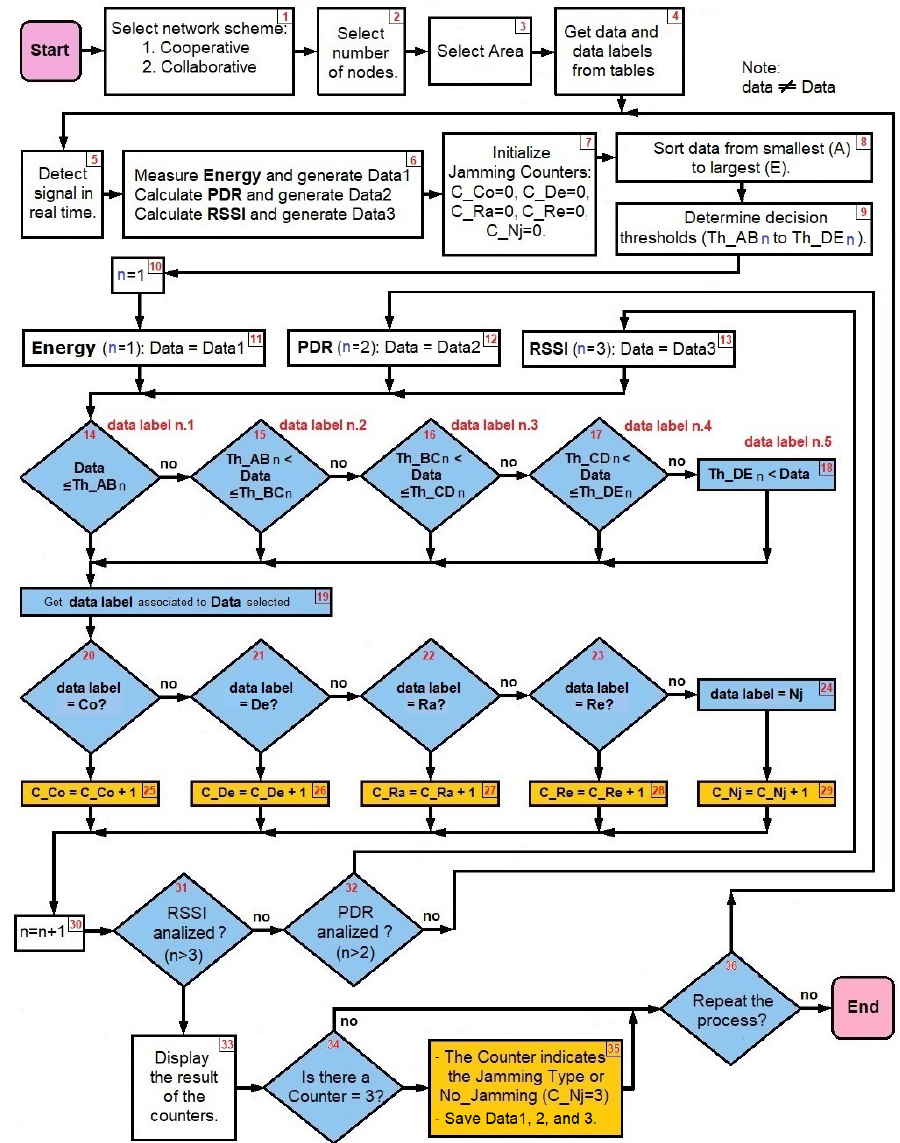
Figure 4. Proposed jamming detection